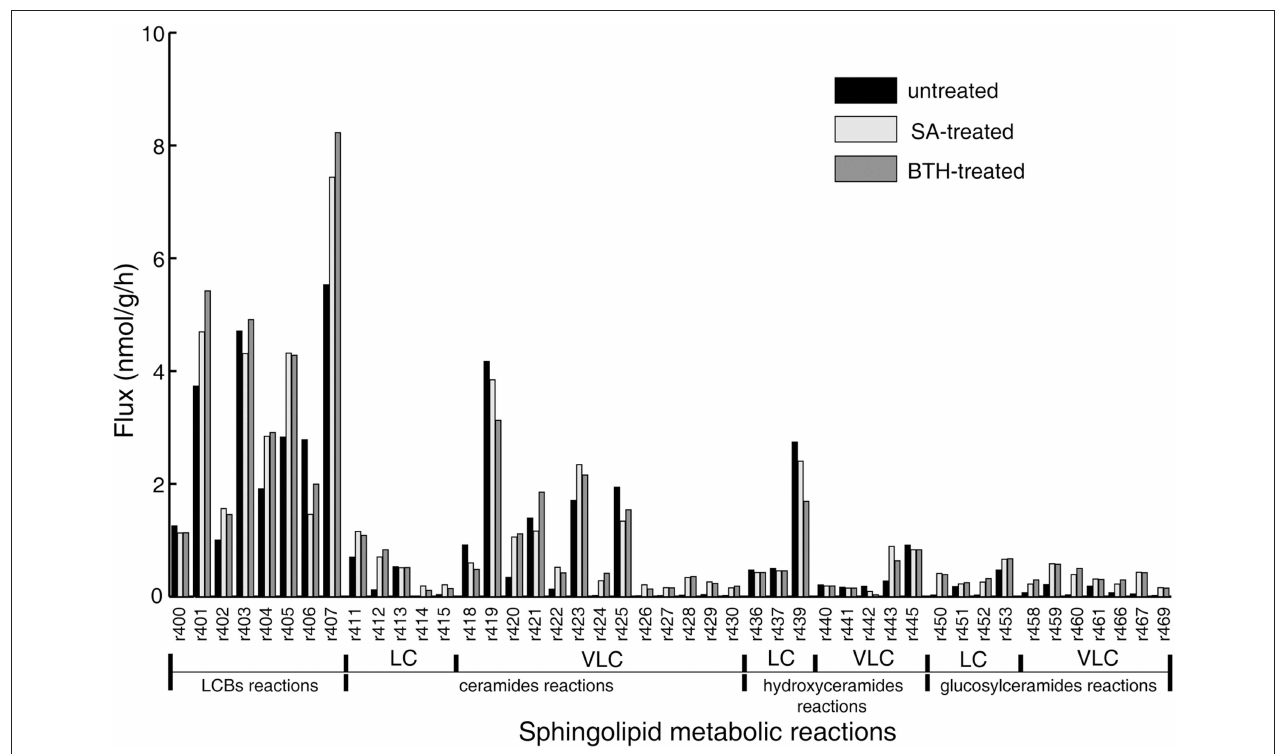
FIGURE 2 | Simulated flux distribution of selected sphingolipid species. The untreated plants (black) and in silico SA (light gray) and BTH-treated plants (gray) were taken from the flux balance model. The effects of exogenous SA and BTH were simulated by